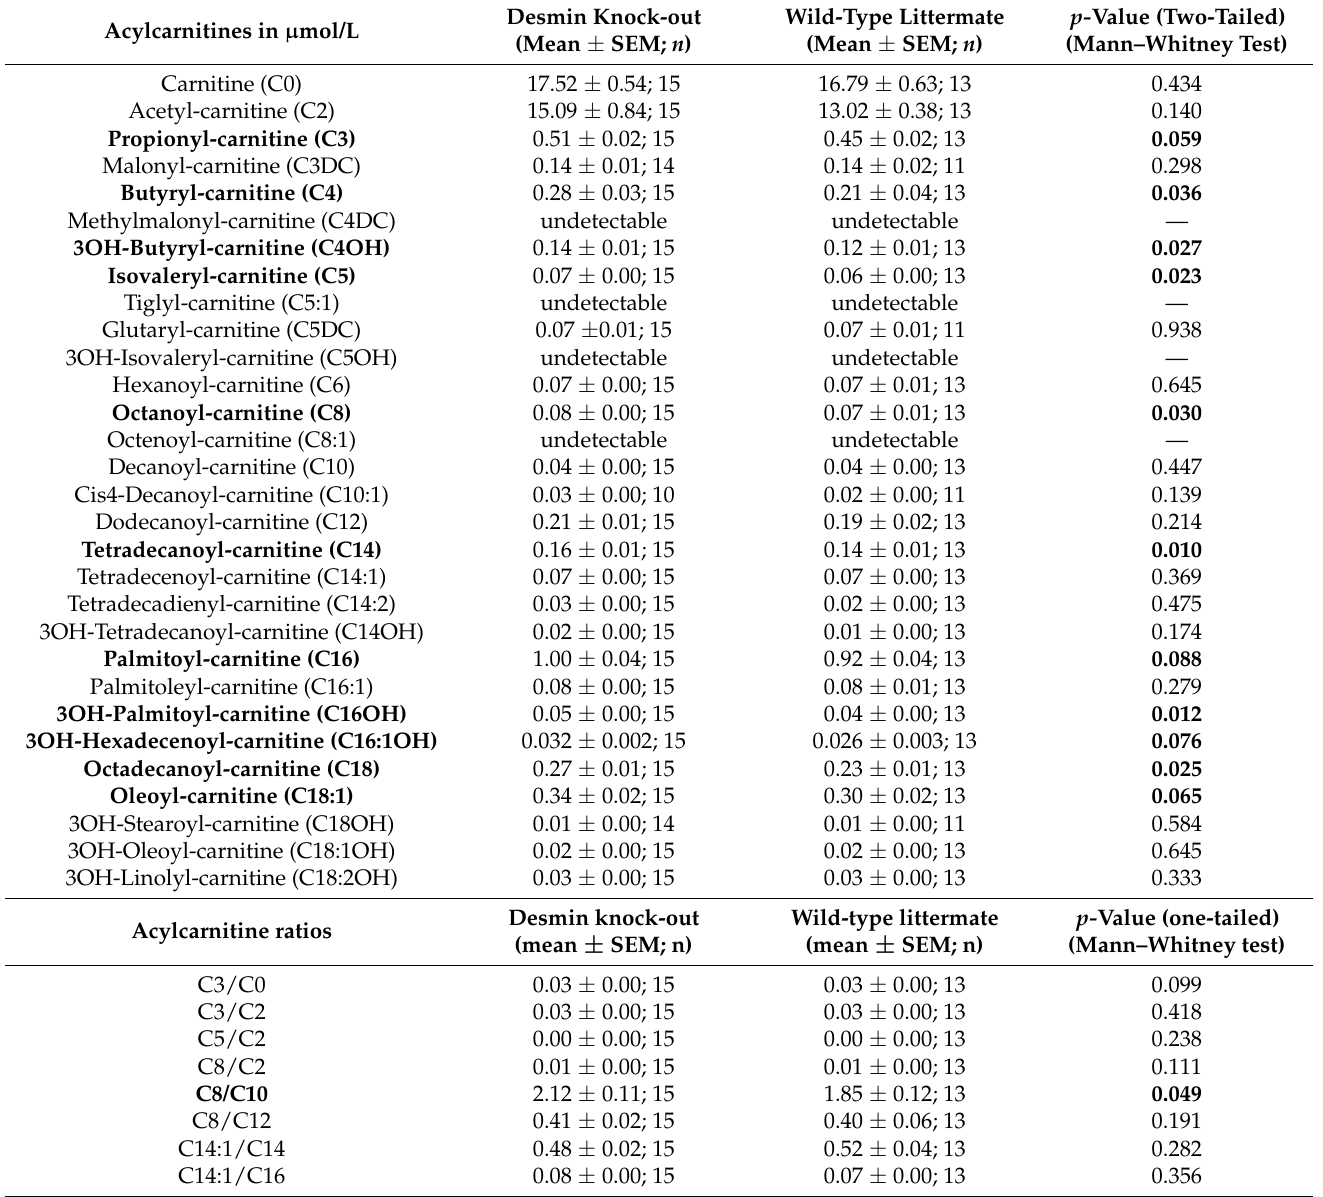
Table 1. Acylcarnitine concentrations were determined from dried blood sample cards derived from fifteen homozygous desmin knock-out mice and thirteen wild-type littermates; in addition, acylcarnitine ratios were calculated. Amino acid concentrations were derived from four homozygous and five wild-type mice. In a few samples, concentrations of specific acylcarnitines were below the detection limit resulting in lower sample numbers (n, as